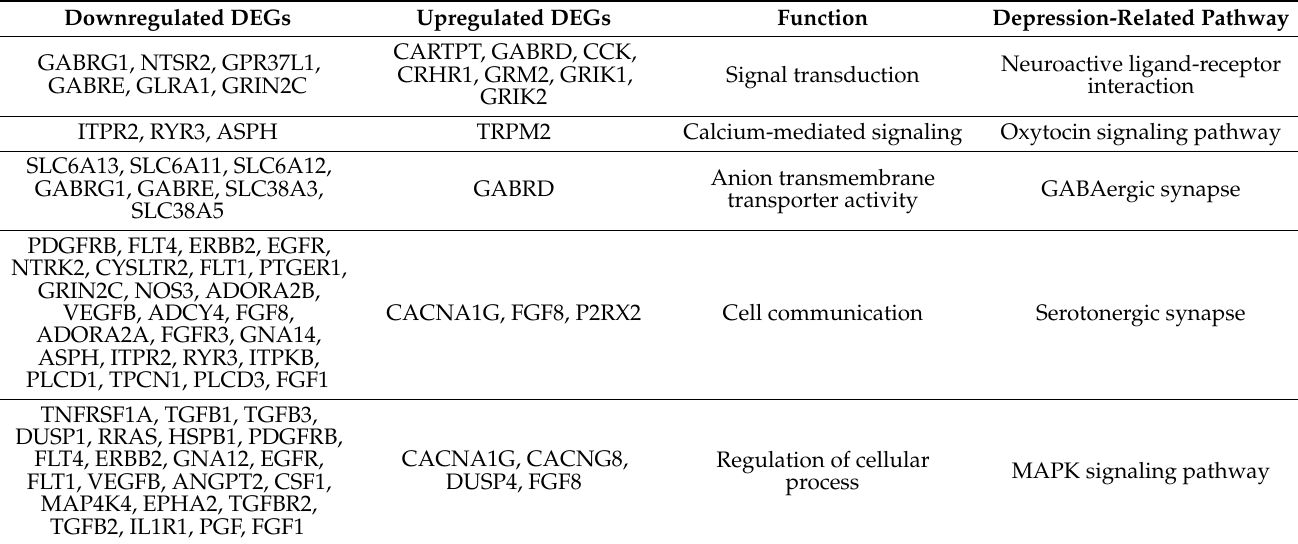
Table 2. Demonstration of down- and upregulated DEGs, which share common functions with depression-related